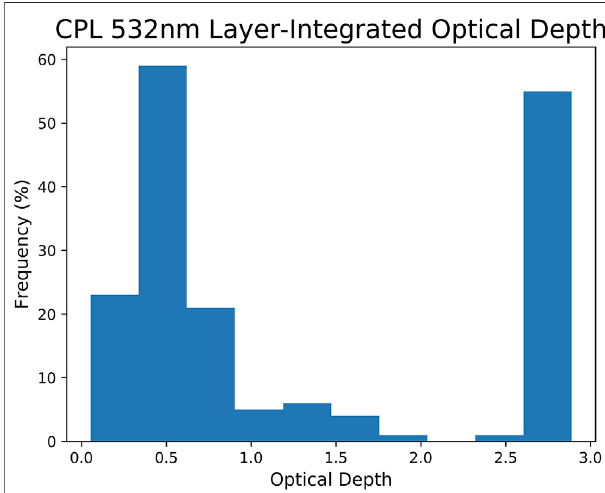
FIGURE 6 | Distribution of the 532 nm layer-integrated optical depth values calculated for all smoke plumes sampled by CPL during the FIREX-AQ campaign.